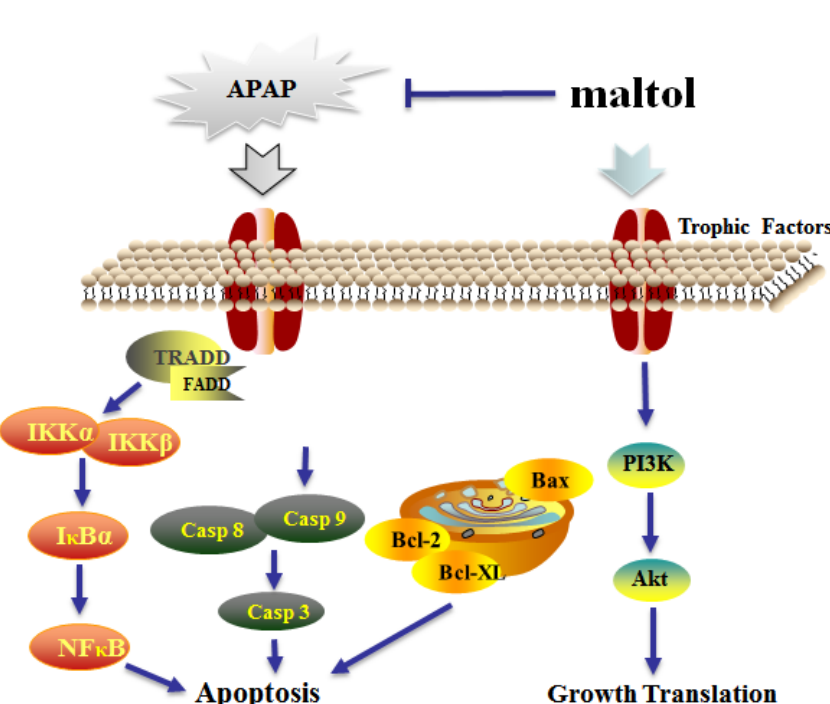
Figure 8. The possible mechanism of action underlying the protective effects of maltol against APAP-induced hepatic injury through inhibition of oxidative stress-mediated activation of the NF-κB pathway and apoptosis and regulation of the PI3K/Akt pathway. Tumor necrosis factor receptor-associated death domain protein (TRADD): Fas-Associated protein with Death Domain (FADD); inhibitor kappa B kinase α (IKK α ); inhibitor kappa B kinase β (IKK β ); Caspase 3; Caspase 8; Caspase 9; B-cell-lymphoma-2 (Bcl-2); B-cell-lymphoma-XL (Bcl-XL); B-associated X (Bax); Protein kinase B (Akt); Phosphatidylinositol 3-kinase (PI3K).